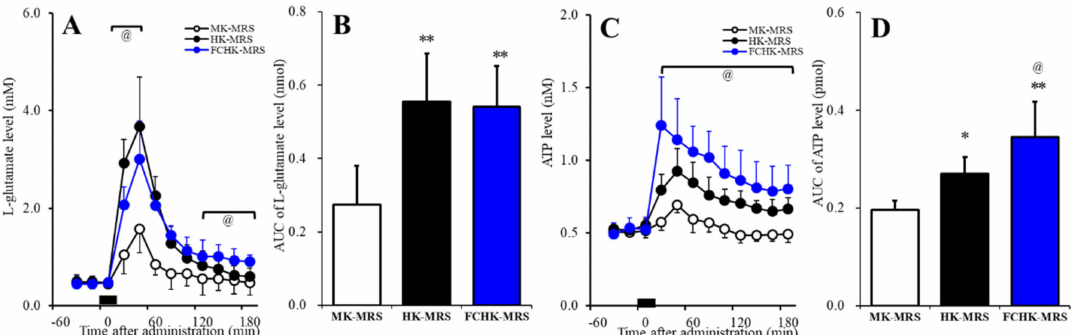
Figure 7. E ff ects of perfusion with 50 mM K + containing modified Ringer’s solution (MRS) (MK-MRS), 100 mM K + containing MRS (HK-MRS), and Ca 2 + -free with 100 mM K + containing MRS (FCHK-MRS) on the extracellular levels of ( A , B ) l -glutamate and (C,D) ATP in the orbitofrontal cortex (OFC). Ordinates: the mean extracellular levels of l -glutamate ( µ M) and ATP (nM) ( n = 6); abscissas: time after perfusion with MK-MRS, HK-MRS, or FCHK-MRS for 20 min (black bars). The area under the curve (AUC) values of the extracellular levels of l -glutamate (nmol) and ATP (pmol) after perfusion with MK-MRS, HK-MRS, or FCHK-MRS during 20–180 min of ( A , B ) are represented in ( C , D ),